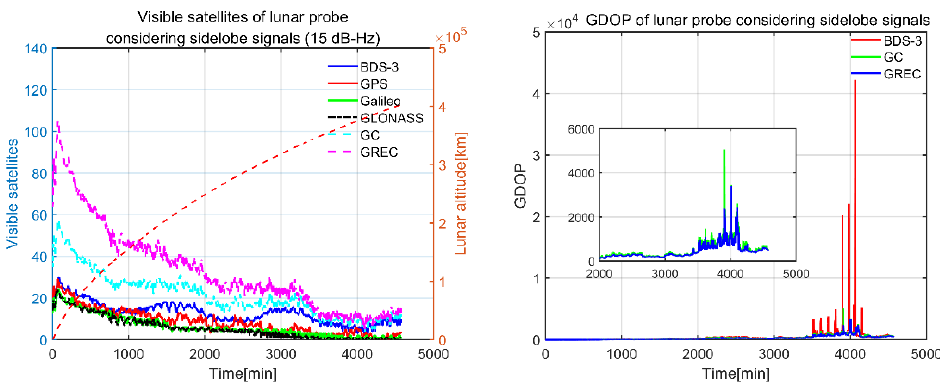
Figure 15. Visible satellites and GDOP of lunar probe with 15 dB-Hz threshold.